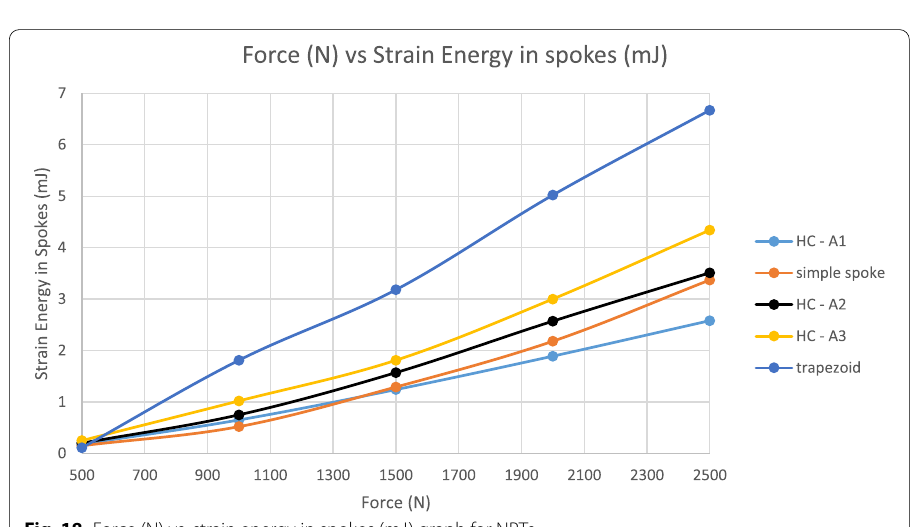
Fig. 18 Force (N) vs. strain energy in spokes (mJ) graph for